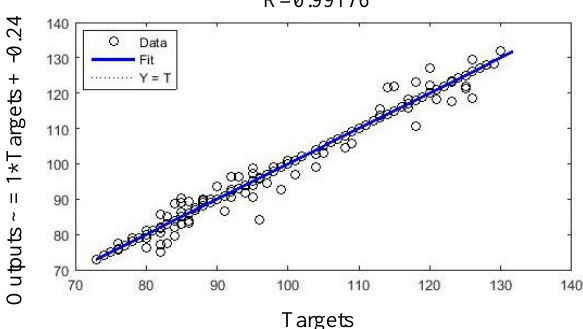
Fig. 14. Correlation between the targets and outputs for RBFNN model.